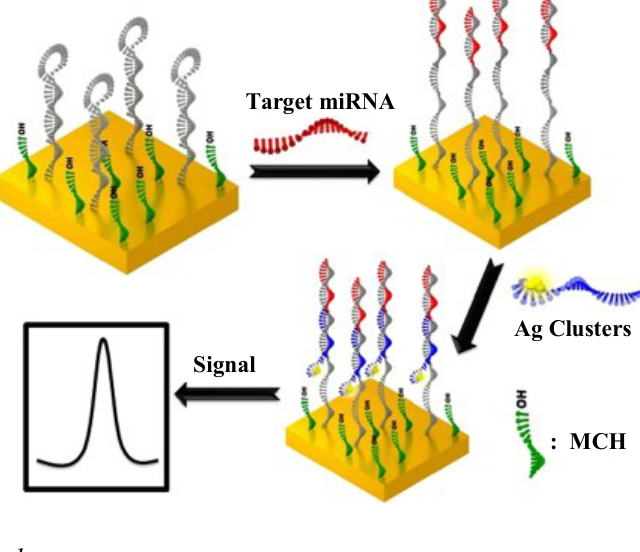
Figure 5. Illustration of electrochemical detection of miRNA using oligonucleotide encapsulated Ag-NCs. Reprinted with permission from [50]. Copyright 2012 American Chemical